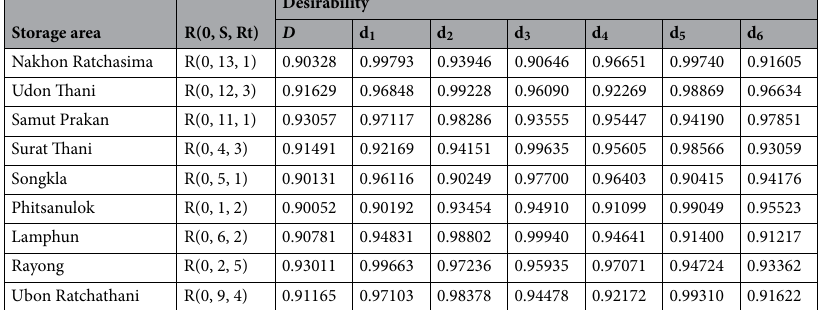
Table 4. Overall (D), individual desirability ( d j ) function levels and BSF routes (Rt) from Rayong (0) to the 9 storage areas (S) of scenario B or